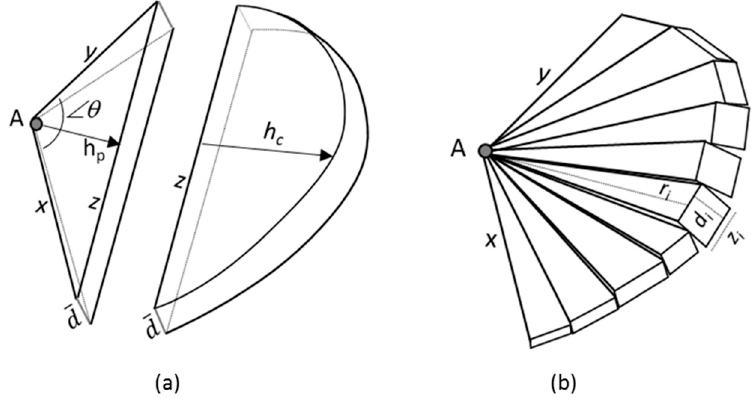
Figure 4. Geometric approximation of sediment wedge volume: ( a ) using a trapezoidal prism and cylinder segment; ( b ) using a series of adjacent trapezoidal pyramids.